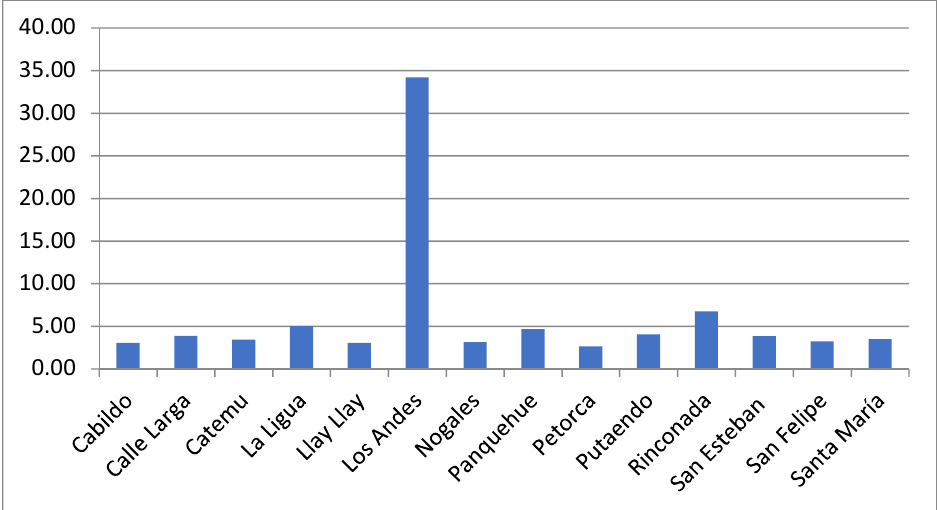
Figure 10. Floating population, 2017 (percentages).